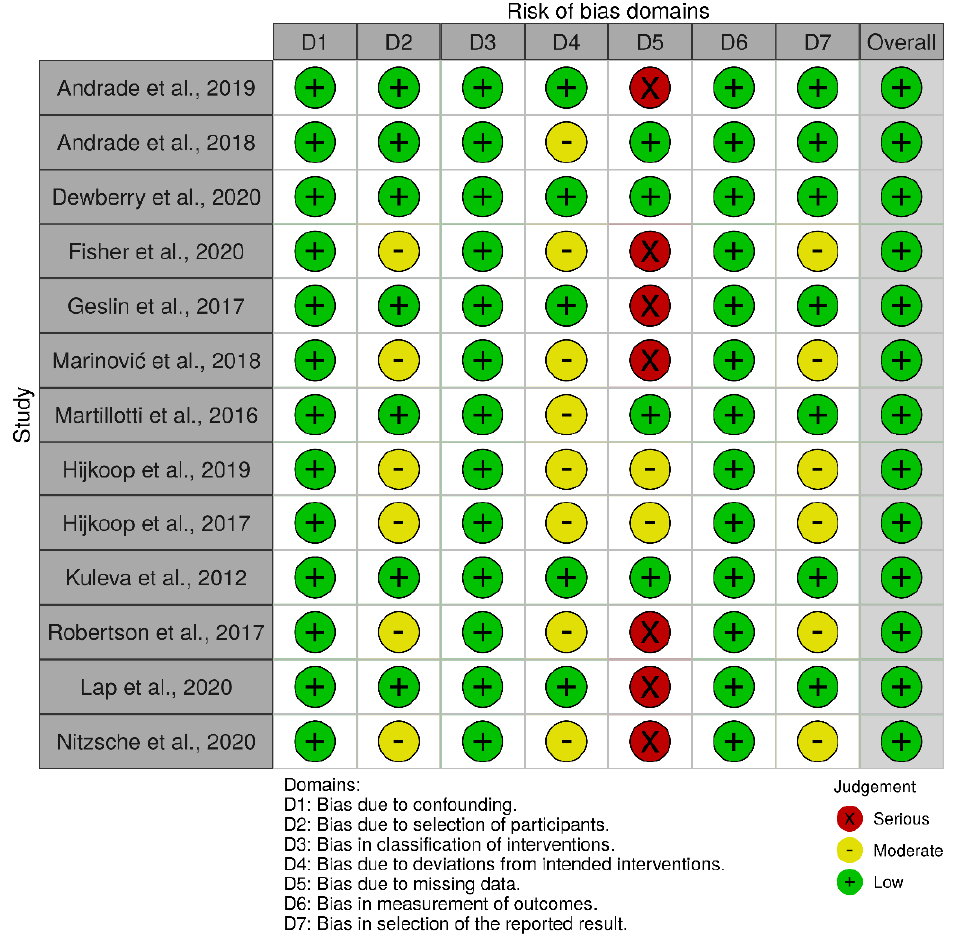
Figure 2. Assessment of the risk of bias.